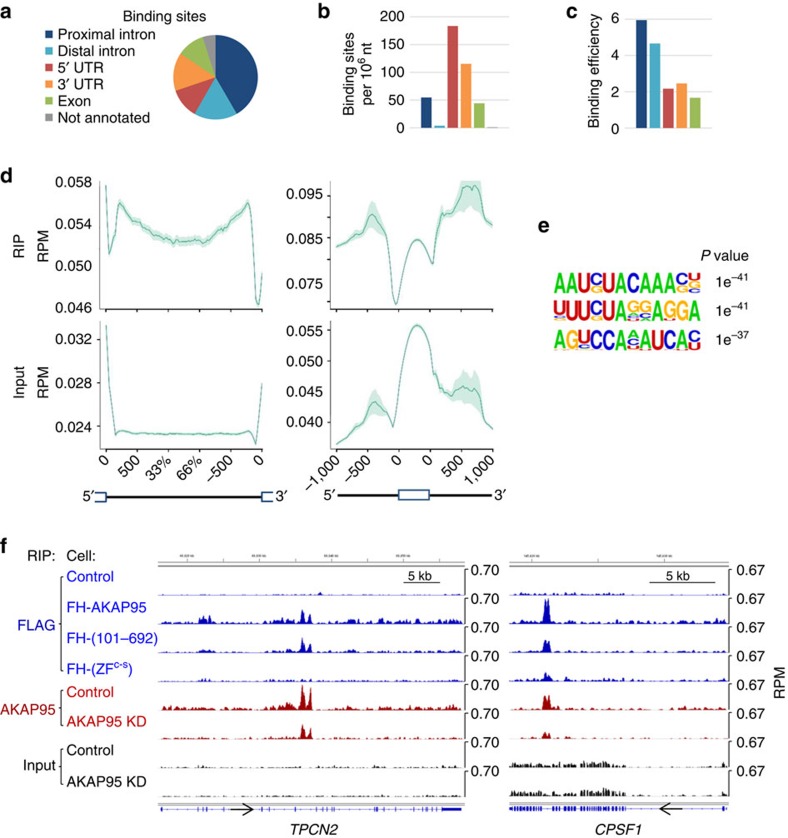
AKAP95 preferentially binds to introns of cellular pre-mRNAs.(a) Distribution of the numbers of endogenous AKAP95 binding sites within different categories of genic regions, as calculated from MACS peak counts. The colour legend applies to a–c. Results in a–e are from anti-AKAP95 RIP assays in 293 cells. (b) Number of AKAP95 binding sites in each 1 million nucleotides of different genic regions. (c) AKAP95 binding efficiencies to different categories of genic regions, as calculated as the ratio of the anti-AKAP95 RIP coverage over the input RNA coverage in the corresponding genic regions. (d) Profiling plots of AKAP95 binding across a composite intron (left) or exon (right). Both the endogenous AKAP95 binding profile (RIP, top) and the corresponding input RNA profile (Input, bottom) are shown. For the diagram at the bottom, solid line, intron; open box, exon. UTR-containing exons are excluded from the analysis on the right. (e) The most enriched sequence motifs bound by AKAP95 in the transcriptome. (f) Representative RIP profiles. In blue are the Anti-FLAG RIP-seq profiles from parental 293 cells (control) or 293 cells stably expressing the FH-tagged AKAP95 wild type or mutants as indicated. In red are the anti-AKAP95 RIP-seq profiles from parental 293 cells (control) or 293 cells stably expressing AKAP95 microRNAs (miR#12, shown as AKAP95 KD). In black are the sequencing profiles of total input RNAs from the corresponding cells for the anti-AKAP95 RIP-seq. All profiles have the same y axis scale for each gene so that they are directly comparable. Arrows on the gene diagrams indicate the direction of the gene transcription.